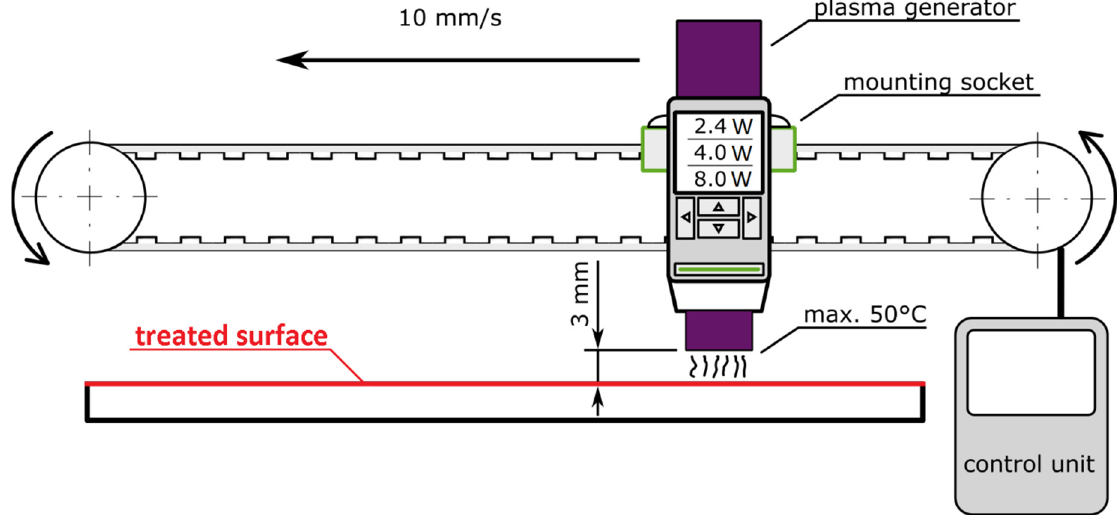
Figure 1. Plasma treatment experimental setup.